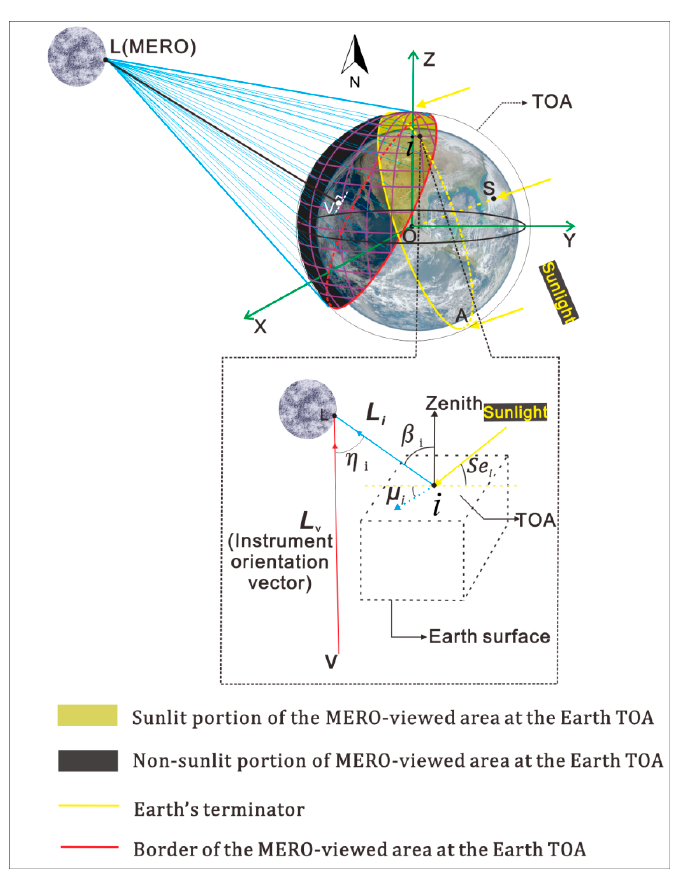
Figure 5. A sketch to illustrate the function for calculating the MERO sensor’s entrance pupil irradiances. β i is the MERO viewing zenith angle; Se i is the Sun elevation; µ i is the relative azimuth angle; η i is the MERO zenith angle of grid node i in the MERO-viewed area at the Earth TOA; and V is the sub-MERO point.